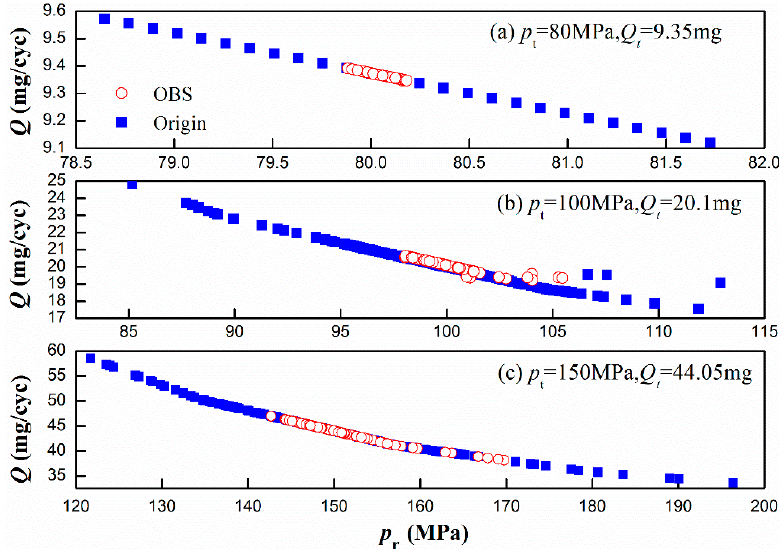
Figure 8. Comparison of position information of state points under three different target pressures of ( a ) p t = 80 MPa, ( b ) p t = 100 MPa, and ( c ) p t = 150